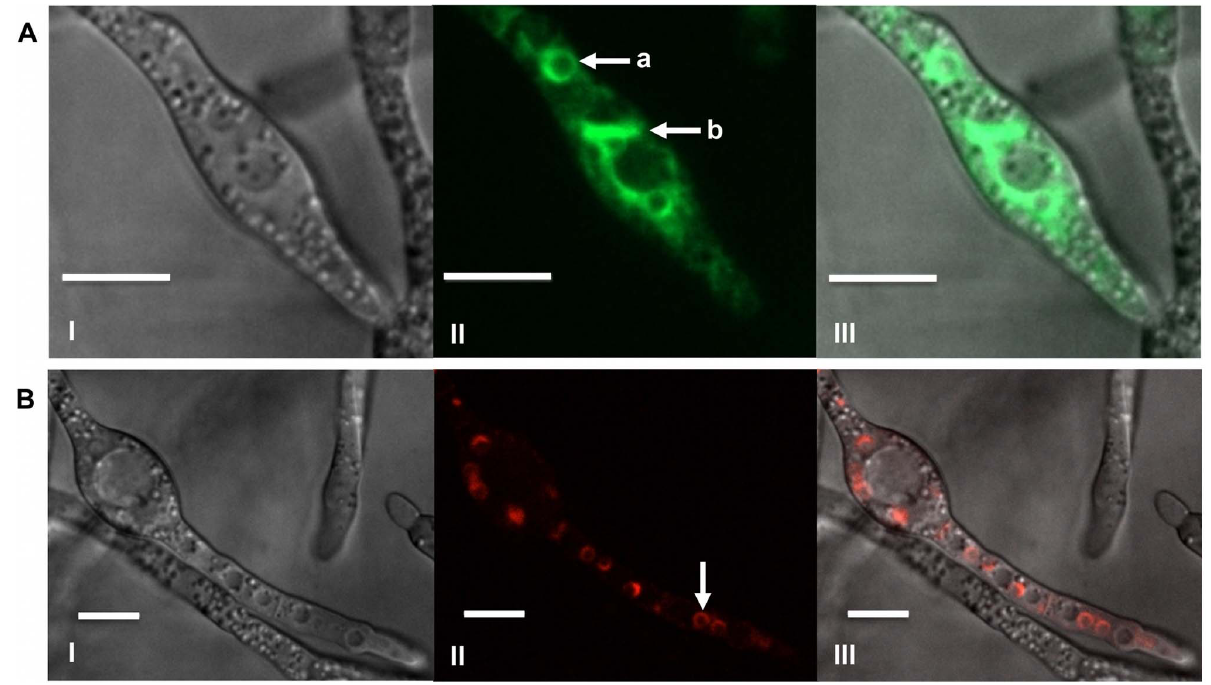
Figure 1. Localization of Tri1p and Tri4p in toxin induced cells. A) Tri1p::GFP localized to a stationary spherical organelle (a) and a membranous network (b) within the cytoplasm of strain PH-1Tri1::GFPA. Confocal bright field DIC (I); GFP (II); and GFP and DIC (III) overlay images of cells are shown. B) Localization of Tri4p::RFP to a stationary spherical organelle (arrow) within the cytoplasm of strain Tri4::RFPB. Confocal bright field DIC (I); RFP (II); and RFP and DIC overlay images are shown. Both strains were incubated in TBI medium for 36 h. Scale bar=10 m m. Hmr1p::GFP is increasingly localized in spherical structures after 24 to 36 hours of incubation (Figure 5b, Figure S2, Video S5), with the greatest fluorescent signal visible at the periphery of toxisomes at 36 hours, as judged by co-localized fluorescence of Tri4p::RFP in doubly tagged strains (Figure 5c).